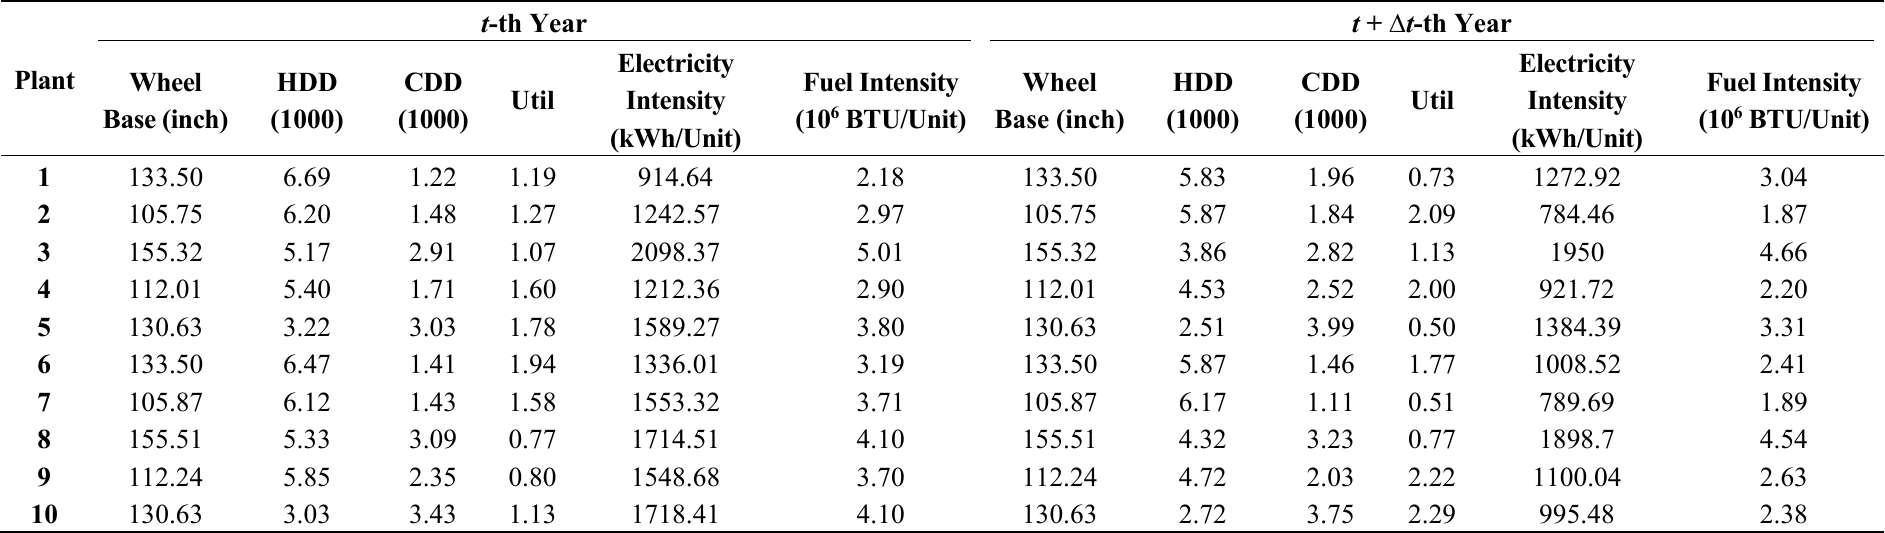
Table 4. Plant data used in the illustrative